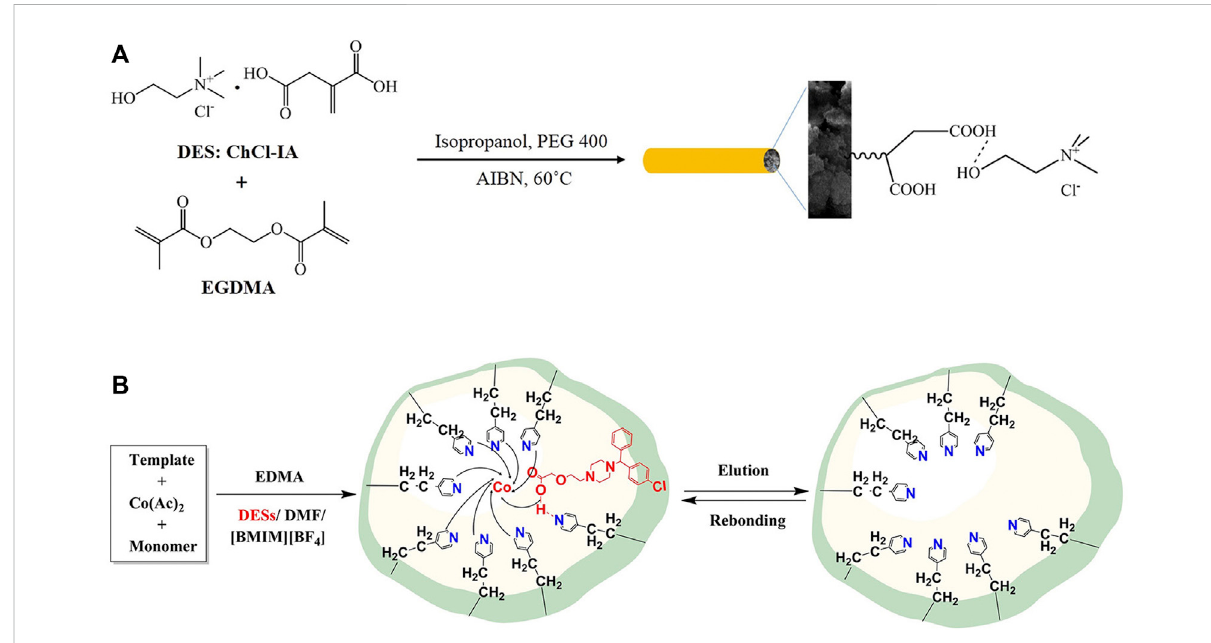
FIGURE 4 (A) : Schematic illustration for fabrication of DES-based monolithic column. Reprinted with permission from Ref. [40]. Copyright 2018 Elsevier (B) : The preparation schematic diagram of DES-Co2+-MIP. Reprinted with permission from Ref. [41]. Copyright 2019 Elsevier.